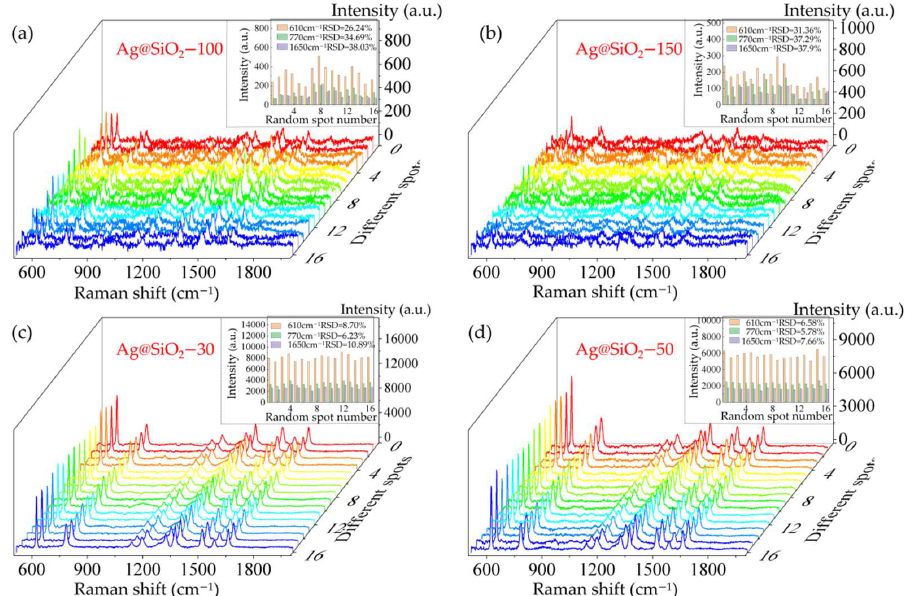
Figure 6. Raman mapping measurements of R6G with concentration of 10 −12 mol/L absorbed on different samples with Ag diameter of ( a ) 100 nm; ( b ) 150 nm; ( c ) 30 nm; ( d ) 50 nm. The correspond-